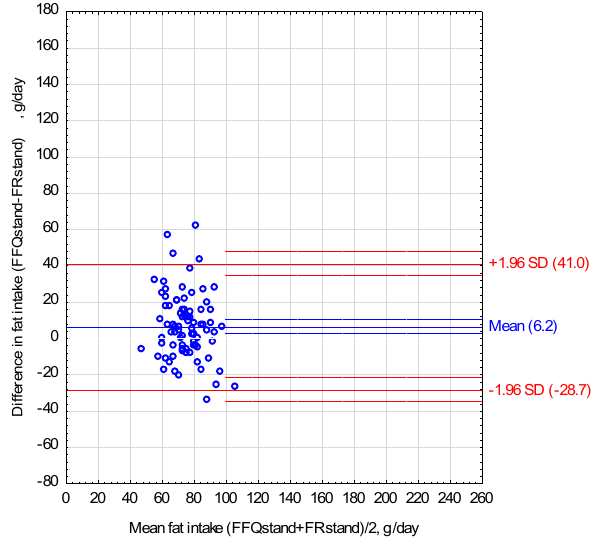
FFQ-crude vs. FR-crude FFQ-standardized vs.